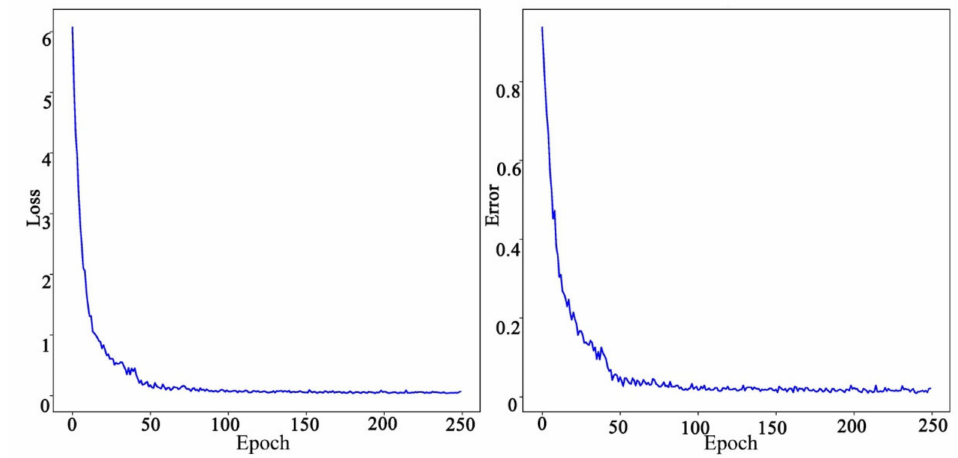
Figure 5. The loss and classification error during the training process (the number of satellite-view images of a target location is